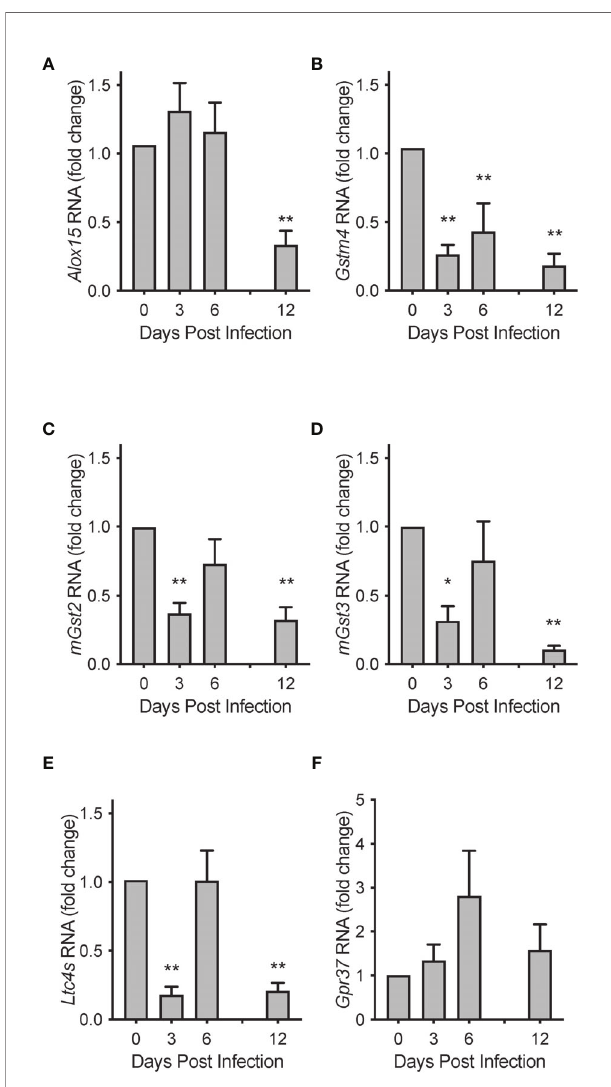
FIGURE 8 | Biosynthetic enzymes for protectins are temporally regulated during mouse RSV infection. Relative RNA expression of (A) Alox15 , (B) Gstm4 , (C) mGst2 , (D) mGst3 , and (E) Ltc 4 s in mouse lung tissue over the course of RSV infection, compared to naïve control. (F) Protectin D1 receptor Gpr37 relative RNA expression in mouse lung tissue over the course of RSV infection. Values are mean of n = 3-4 per group ± SEM and represent 2 separate experiments. * p < 0.05, ** p < 0.01 vs naïve by one-way ANOVA with Holm-Sidak ’ s multiple comparisons